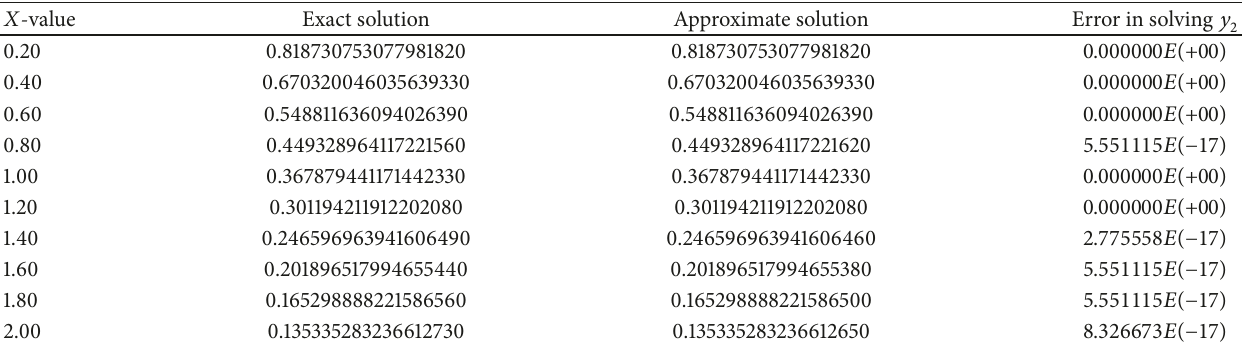
Table 6: Exact and approximate solutions for solving 𝑦 2 using the developed method.